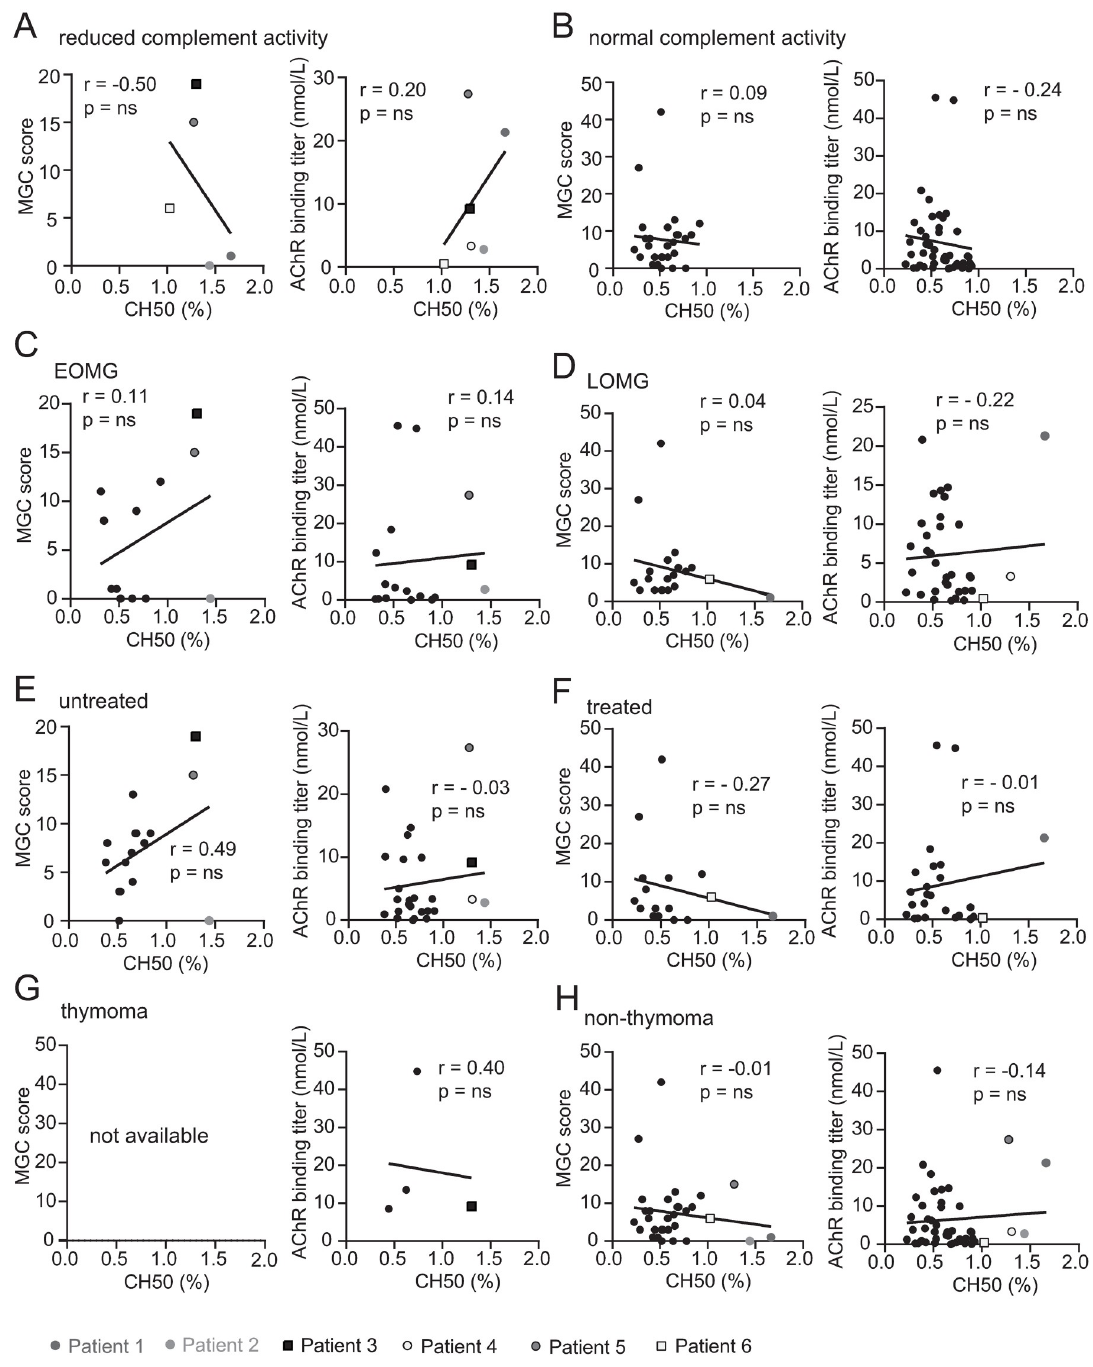
Fig 2. Correlation between complement activity and MG patient subcohort demographics. Correlation tests between complement activity to clinical status and autoantibody titer in different MG patient subcohorts defined by complement activity, age of disease onset, treatment status, and thymoma. (A-H) Correlation of complement activity with MGC score (first and third columns) and AChR antibody titer (second and fourth columns). The subcohorts are defined by complement activity (A and B), age of disease onset (early onset MG (EOMG; C); late onset MG (LOMG; D)), treatment status (E and F) and thymoma status (G and H). Limited specimens (n = 1) in the thymoma category with matching MGC scores prohibited correlative analysis (G left panel). The linear regression is shown with Spearman correlation values. The Bonferroni correction was used to adjust for multiple tests. Patient 1–6 (Table 2) are individually illustrated (see legend) for each panel.